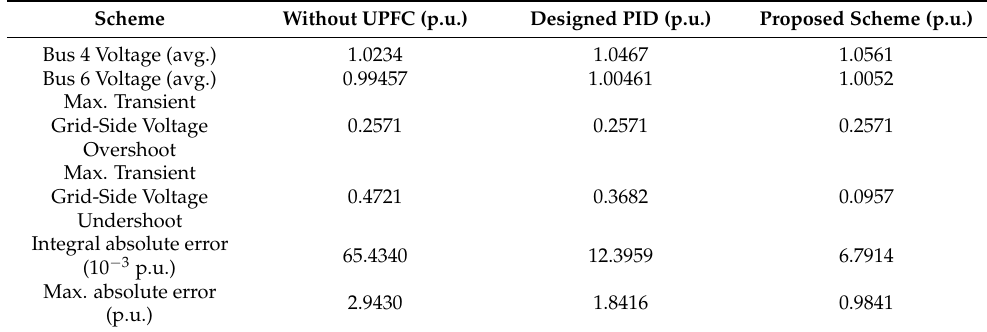
Table 2. Dynamic performance comparison under three phase short circuit fault. Scheme Without UPFC (p.u.) Designed PID (p.u.) Proposed Scheme (p.u.) Bus 4 Voltage